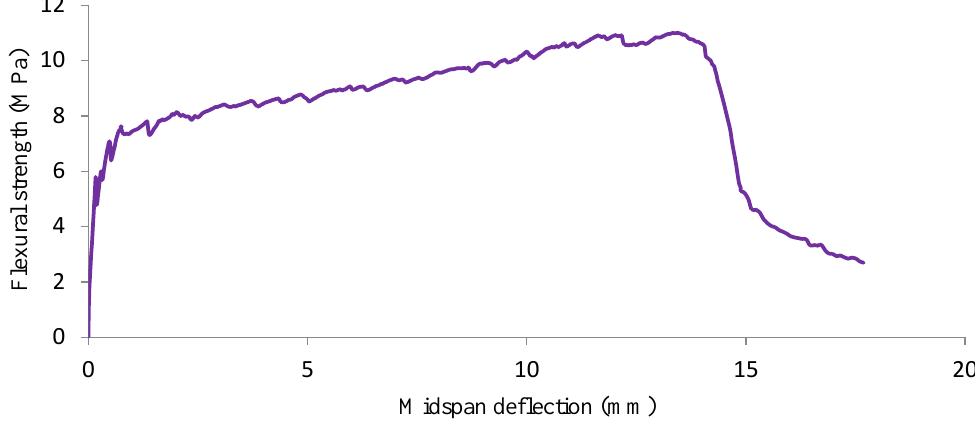
Figure 18. Flexural strength versus midspan deflection curve of the optimized mixture . Table 12. Experimental validation of the optimized Mixture.